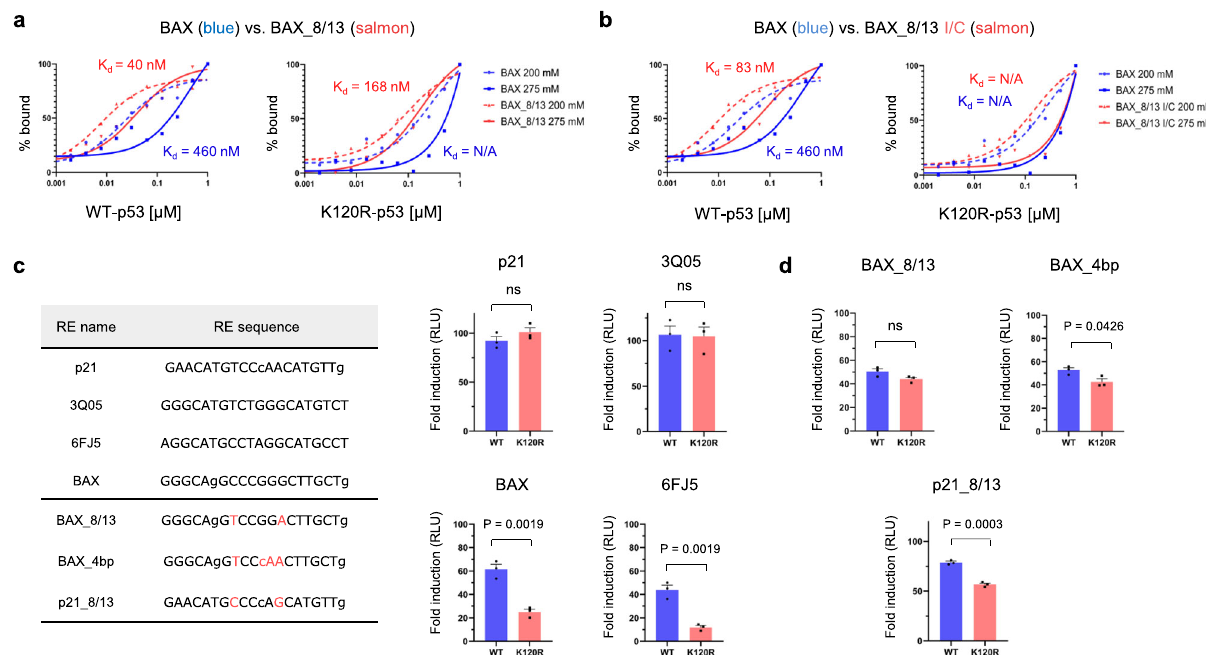
Fig. 4 Rewriting the RE code reprograms p53 function in vitro and in cells. a G/C to A/T conversions at positions 8 and 13 in BAX RE increase its af fi nity for WT p53 (from 460 nM to 40 nM, left) and restore K120R-p53 binding (right). b G/C to I/C conversions at positions 8 and 13 in BAX RE increase its af fi nity for WT p53 (from 460 nM to 83 nM, left), but do not have an impact on K120R-p53 binding de fi ciency (right). Data are shown as graphs depicting the percent of bound protein and plotted as a function of the protein concentration (from 0.001 to 1 μ M, in log scale). Two independent measurements were performed at “ low-salt ” (dashed curves) and “ high-salt ” (solid curves) buffer conditions. Relevant K d values measured at high-salt concentrations are depicted on the graphs. I/C inosine/cytosine. N/A not available. c A luciferase reporter plasmid containing p21, 3Q05, 6FJ5, BAX, BAX_8/13, BAX_4bp or p21_8/13 RE (nucleotide sequences are listed in table) were co-transfected with an empty vector, WT or K120R-p53 expression plasmid. Twenty-four hours after transfection cells were harvested and luminescence was measured. K120R-p53 has identical activity as WT p53 protein on A/T-rich p21 and 3Q05 REs, but is defective in trans-activating G/C-rich BAX and 6FJ5 REs. These data con fi rm K120R-p53 binding behavior observed in vitro. Data are presented as a fold change of measured luminescence in either WT (blue) or K120R (salmon)-p53-expressing cells over luminescence measured in cells transfected with an empty vector (no p53). d Substituting G/C to A/T bps in BAX RE ( “ BAX_8/13 ” , converted nucleotides are depicted in salmon letters) or changing positions 8 – 13 from CCCGGG to TCCCAA ( “ BAX_4bp ” ) restores K120R-p53 transactivation activity. Conversely, substituting A/T to G/C bps in p21 RE ( “ p21_8/13 ” ) reintroduces K120R de fi ciency. Graphs in panels c and d show cumulative data from three independent experiments (mean ± s.e. m.). Two-tailed unpaired Students t -test was used for statistical analysis in panels c and d . RLU, relative light units. Source data are provided as a Source Data fi